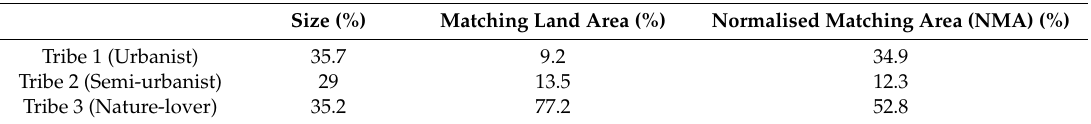
Table 2. A comparison of the housing preferences based on the tribal classification and participant domicile with the areal disbrituion generated from the modelled revealed prefernces in Tampere. Size (%) Matching Land Area (%)